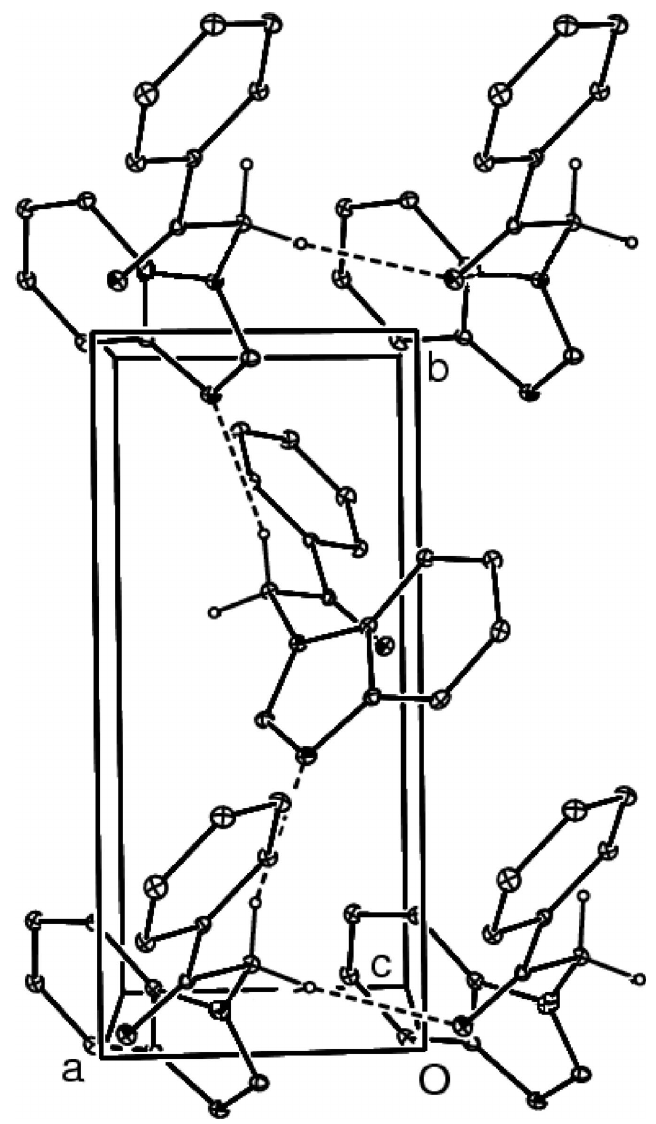
A partial packing diagram of the title compound, viewed along the c axis. Hydrogen bonds are shown as dashed lines. H atoms not involved in hydrogen bonding have been omitted for